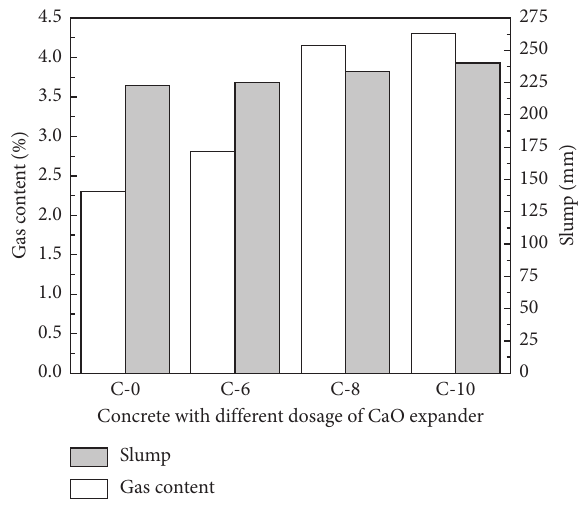
Figure 4: Air content and slump of different calcium oxide